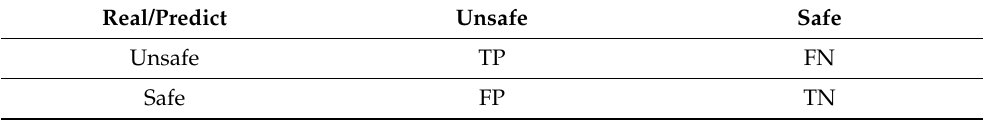
Table 6. Confusion matrix of Binary classification.